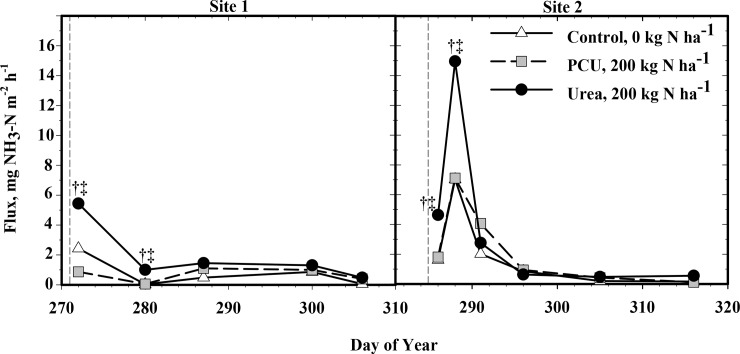
Passive flux of NH3-N measured on multiple individual days for Sites 1 and 2 from application of 0 (Control) and 200 kg N ha-1 polymer coated urea (PCU) or urea.Significance indicated by † (urea greater than control) and ‡ (urea greater than PCU) where P = 0.05. Vertical dashed lines indicate fertilizer application.